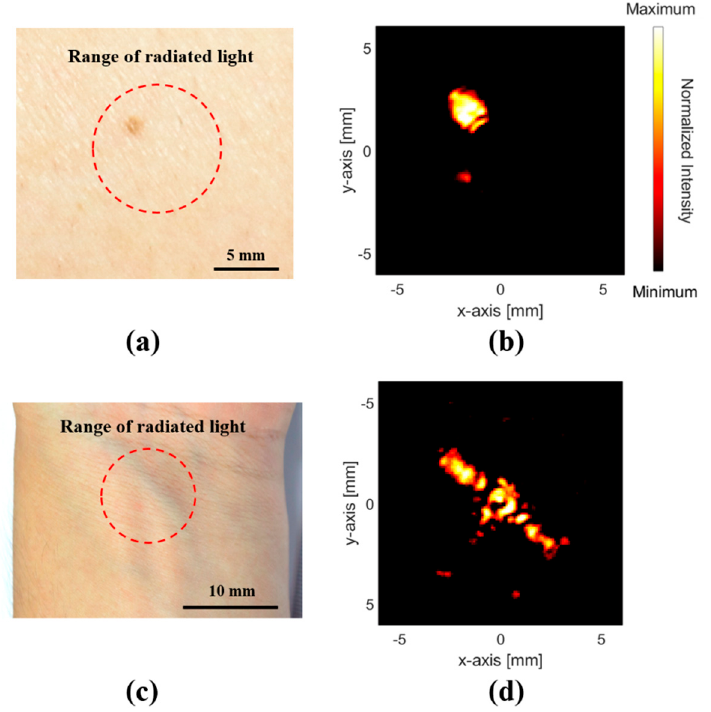
Figure 6. ( a ) Optical and ( b ) PA images of mole in arm. ( c ) Optical and ( d ) PA images of vein in wrist.